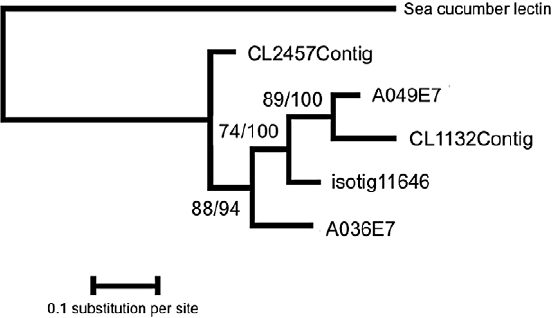
Figure 4. Phylogenetic relationship of CEL-III lectins inferred from ML and Bayesian analyses. Numbers beside nodes indicate ML/Bayesian posterior bootstrap probabilities.